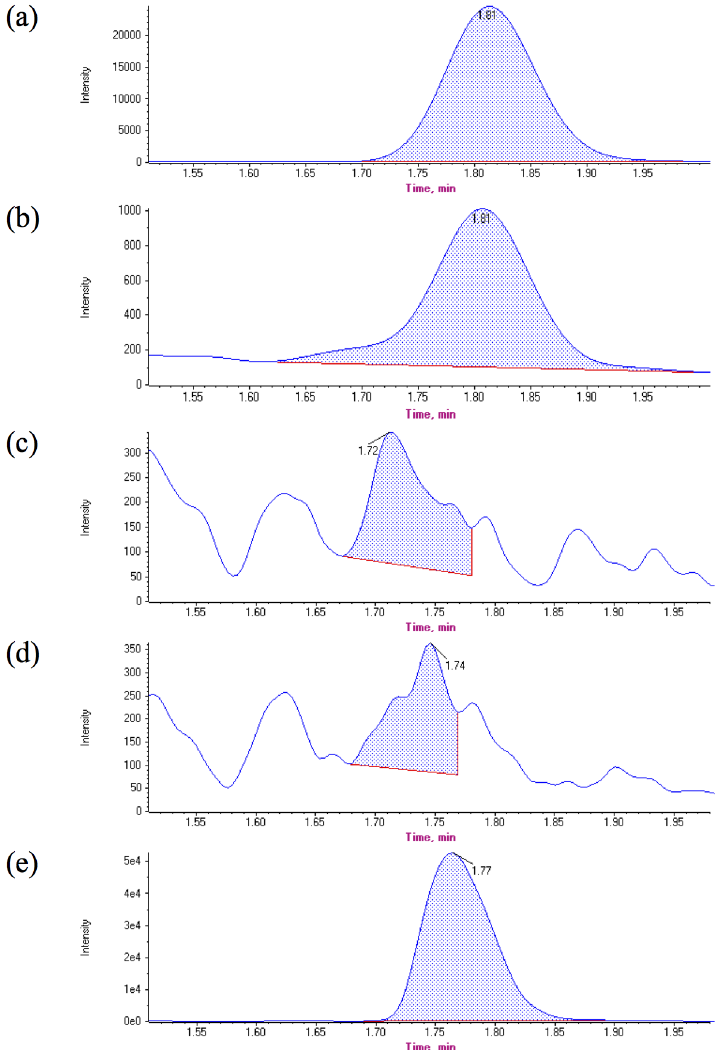
microgram per liter (c) Control 1 (d) exposed fish and (e) control